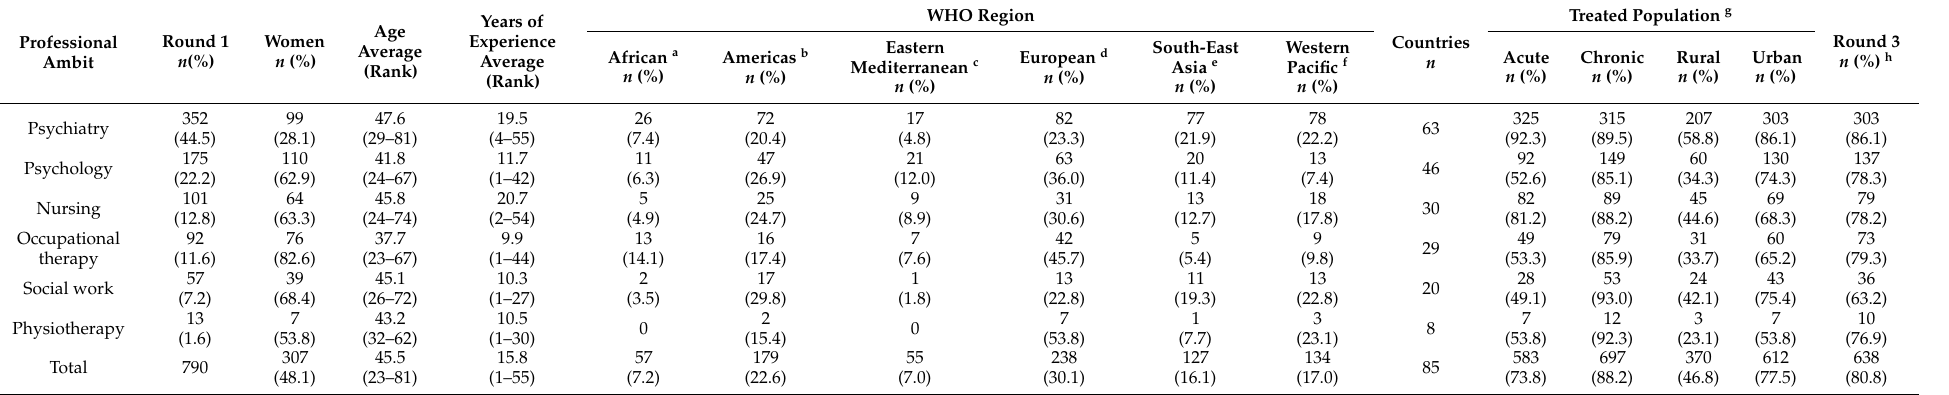
Table 1. Socio-demographic and professional characteristics of the total sample of participants in the Delphi